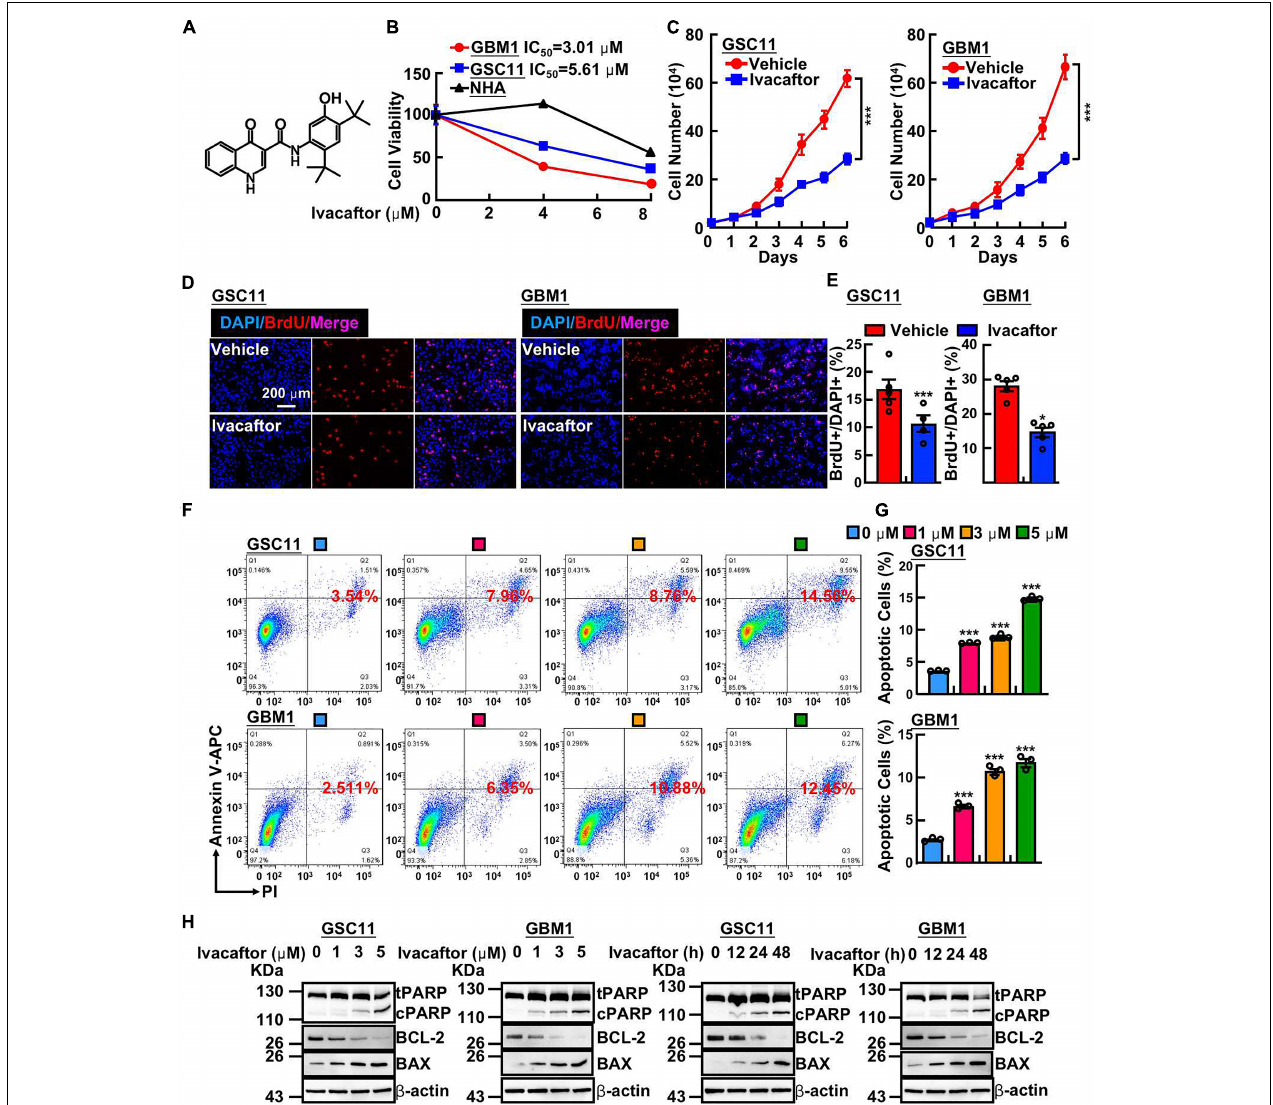
FIGURE 1 | Ivacaftor inhibits GSCs proliferation and induces cellular apoptosis. (A) The chemical structure of FDA-approved drug ivacaftor. (B) Cell viability of indicated cells treated with various concentrations of ivacaftor. (C) The cells proliferation of GSC11 (left panel) and GBM1 (right panel) treated by 5 mM ivacaftor. (D,E) Representative images of BrdU incorporation assay in GSC11 (left panel) and GBM1 (right panel) treated with or without ivacaftor. Scale bar: 200 mm. (E) Quantification data for (D) . (F,G) Ivacaftor treatment significantly increases cellular apoptosis in GSC11 and GBM1 cells determined by flow cytometry assay. (G) Quantification data for (F) . (H) Apoptotic cell markers were dramatically increased following treatment with indicated concentrations of ivacaftor. tPARP, total PARP; cPARP, cleaved PARP. Data are shown as means ± SEM, * P < 0.05; *** P < 0.001; t